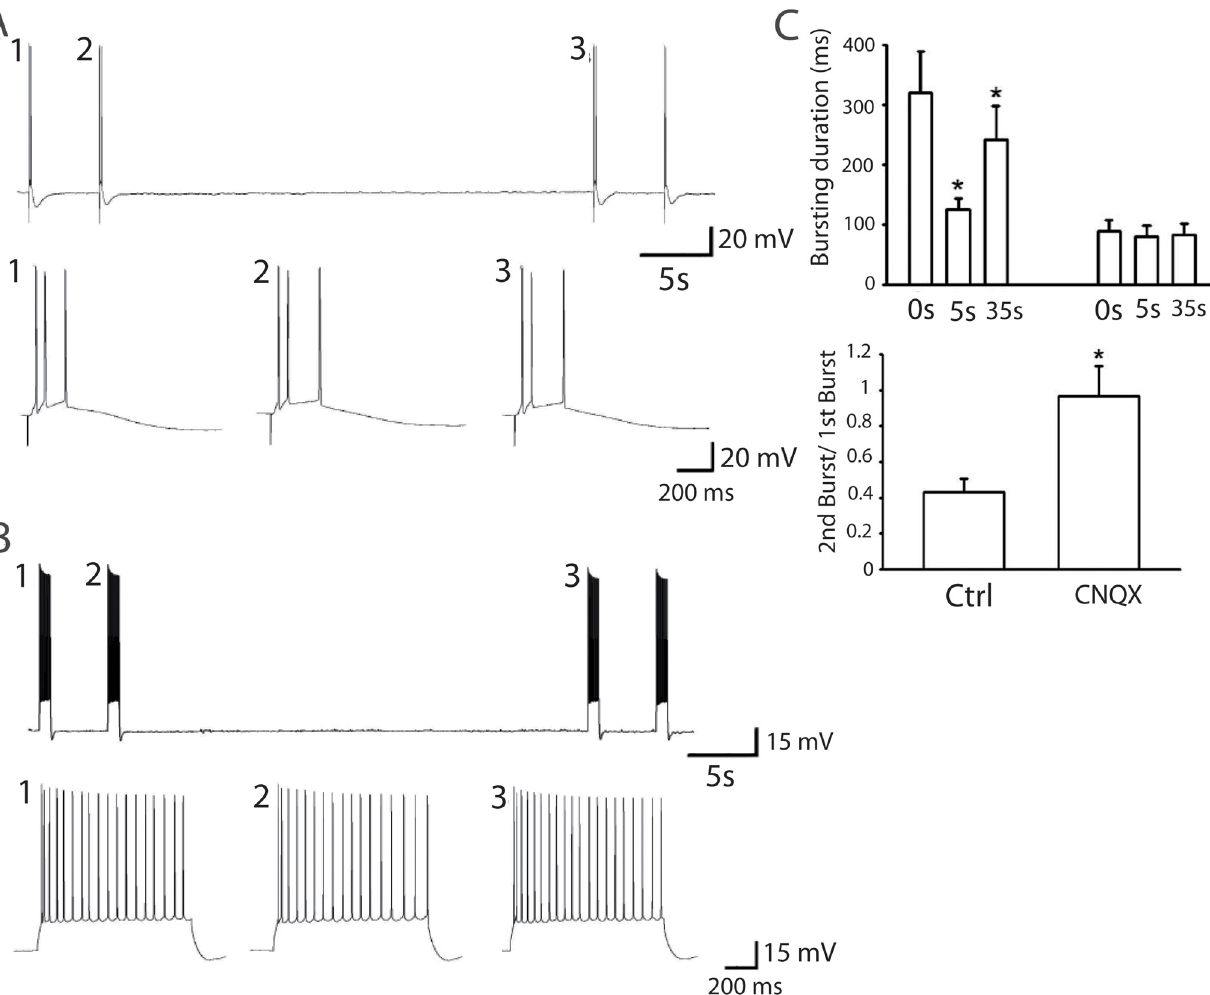
Fig 6. Calcium-dependence of reverberation bursts in large networks. (A) Evoked burst triggered by a single stimulation of Schaffer collaterals in hippocampal slices at 5 and 35 s intervals in the presence of low [Ca 2+ ] solution (1.3 mM [Ca 2+ ] and 2.5 mM [Mg 2+ ]). (B) Comparison of the burst durations for two different calcium concentrations, leading to a reduction of the 1st burst duration (35 seconds interval burst) but not the 2nd burst (5 seconds interval burst), after low [Ca 2+ ] solution application. ( * P < 0.05, compared with 0 s, Student ’ s paired t-test). (C) Calcium reduction is modeled by changing the parameter X , which determines the steady state value of the facilitation variable x . (D) First and second burst durations for value of X = 0.50 (control Table 1) and X = 0.4925, which describes the burst duration variations due to calcium concentration changes observed in A and B